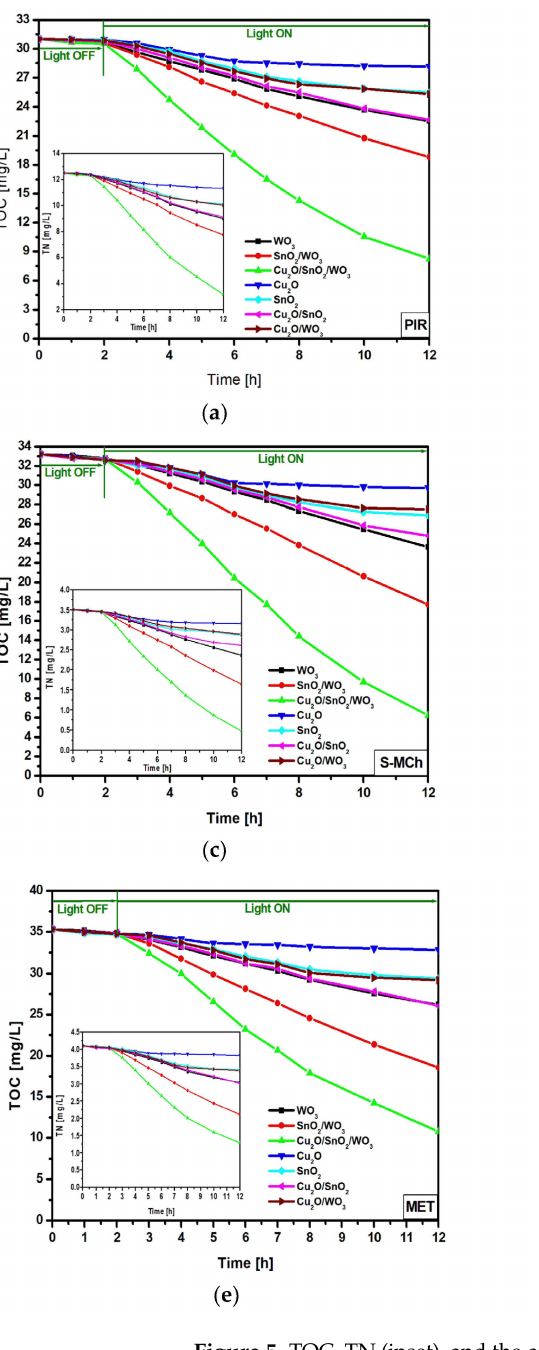
Figure 5. TOC, TN (inset), and the corresponding kinetics toward PIR ( a , b ), S-MCh ( c , d ), and MET ( e , f ). The kinetic evaluation indicates that the WO 3 monocomponent sample has small and similar constant rates for all three pollutant molecules, which is a consequence of reduced light absorbance and high charge carrier recombination. Larger differences in the constant rates were obtained for SnO 2 /WO 3 and Cu 2 O/SnO 2 /WO 3 samples, which confirm the photocatalytic removal efficiency results. The insertion of an additional semiconductor component will increase the photocatalytic efficiency where each partner will play a sig- nificant role on the charge carrier photogeneration and mobility. These characteristics are essential in order to produce oxidative ( · OH) and superoxidative ( · O 2 − ) species able to induce pollutant mineralization